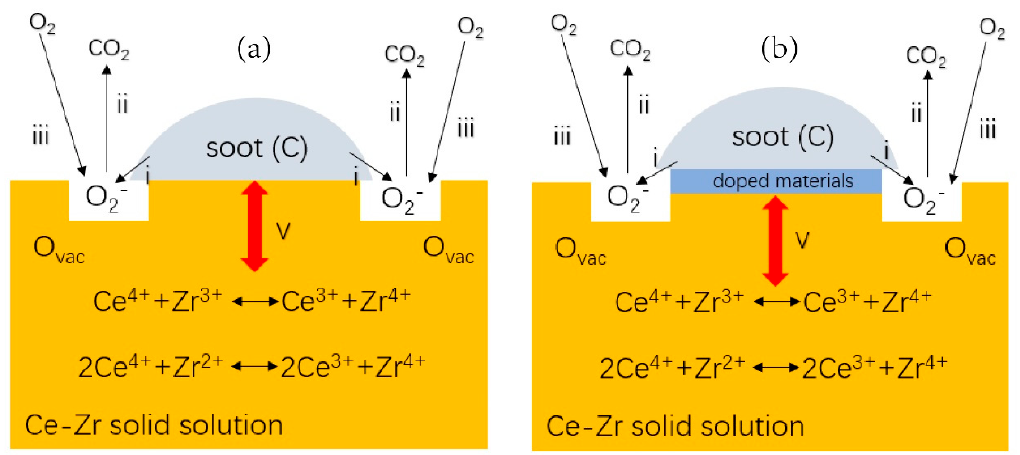
Figure 9. Catalyst reaction process ( a ) Ce-Zr solid solution, ( b ) Ce-Zr solid solution doped with K, Co or Zr.